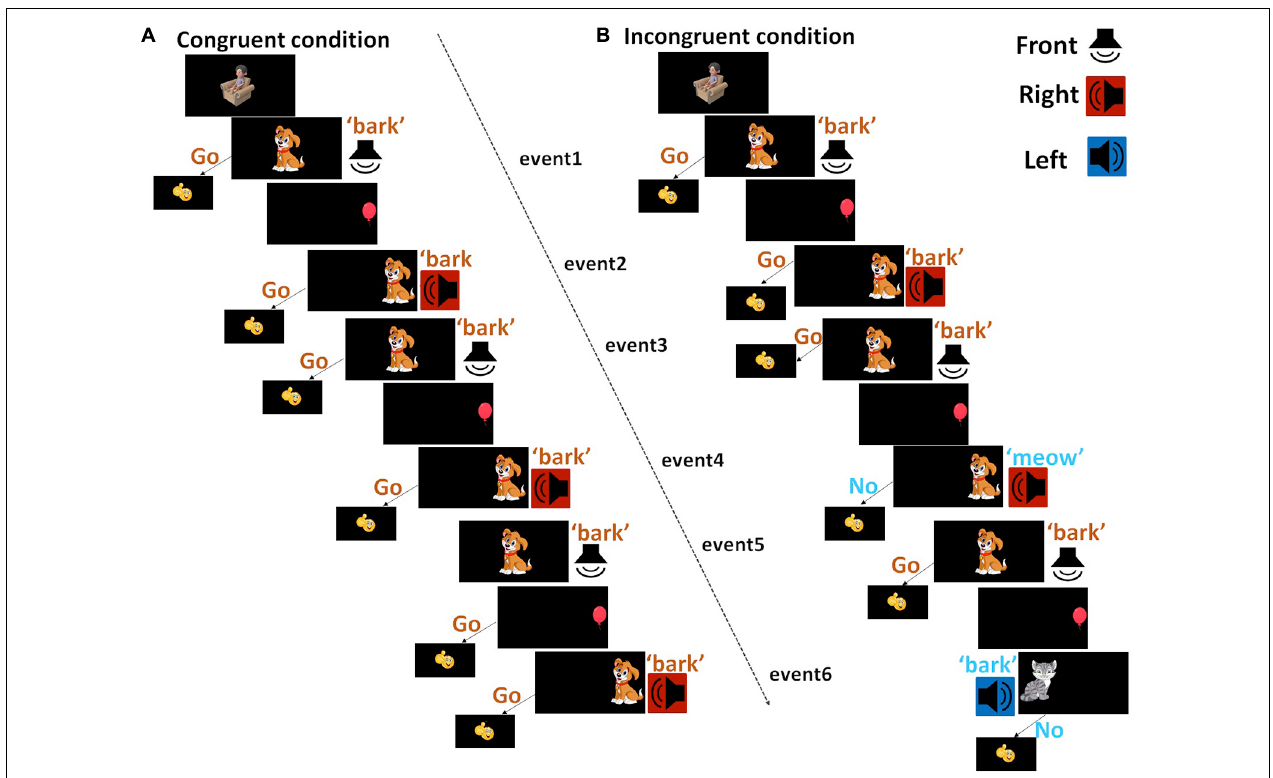
FIGURE 1 | Diagram of testing conditions. The image of a cartoon child sitting in the armchair before the onset of each trial was aimed to remind children to sit still during fNIRS data collection. Images were presented at the center, left, or right side of the monitor. Sounds were presented from loudspeakers at the front (white), left (blue) or right (red) side. (A) A congruent trial started with a dog appearing at the center of the monitor, with a bark sound being played from a front loudspeaker. Then a balloon was shown on the left or right side of the monitor, followed by the dog image appearing on the same side and a loudspeaker playing sound from the corresponding location. Different from the congruent trial, (B) in an incongruent trial (blue), after the balloon, children might see a dog and hear a meow, or see a cat and hear a bark, at the same or different locations as the balloon. A congruent block consisted of three congruent trials; an incongruent trial consisted of one congruent trial and two incongruent trials. Each trial consisted of two events that required response, i.e., Go for the congruent and NoGo for the incongruent events, from